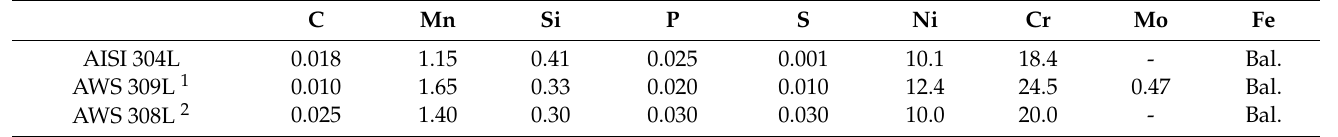
Table 2. Composition of the base metal and the filler (% by weight).